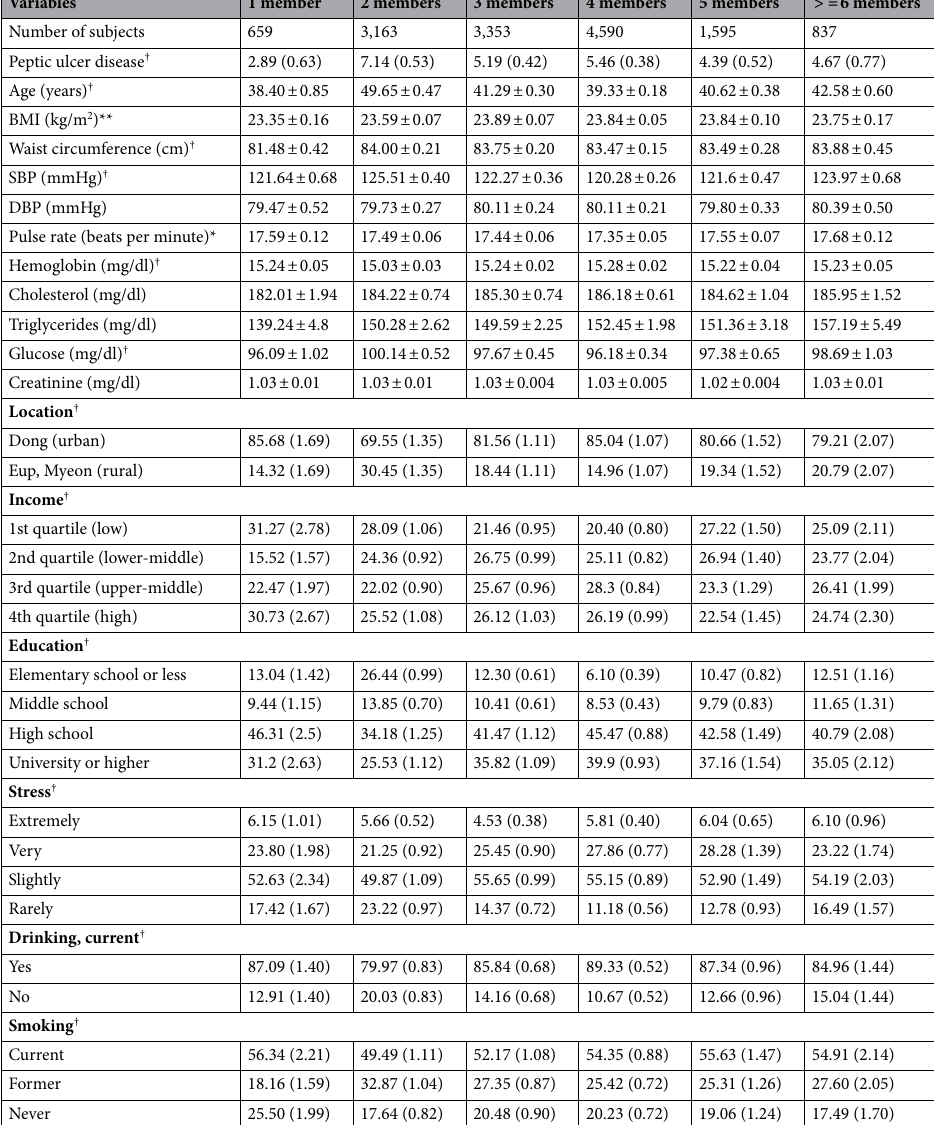
Table 2. General characteristics of the subjects across categories of the number of household members for Korean men. BMI body mass index; SBP systolic blood pressure, DBP diastolic blood pressure. *: p < .05; **: p < .01; † p < .001. *, ** and † indicate p values of the difference across categories of the number of household members. These p values were obtained from a general linear model for continuous variables and from Rao-Scott chi-squared tests for categorical variables. Continuous variables are summarized as the means ± SE (standard error). Categorical variables are summarized as percentages (SE). All statistical analyses were performed using weight, cluster and stratification parameters to account for the complex sampling